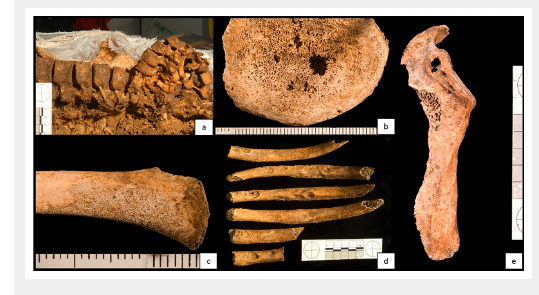
a: Angular kyphosis of the spine due to destruction of the vertebral bodies of the fourth to eighth thoracic vertebrae as found in situ (grave 94), the thoracic region of this skeleton was recovered in a cast due to the pathological alterations; b: lytic lesions in the endplate of a lumbar vertebra (grave 116); c: new bone formation on the vertebral end of a rib (grave 82); d: lytic lesions and new bone formation on the visceral rib surfaces (grave 127), e: lytic lesions in the scapula (grave 127).